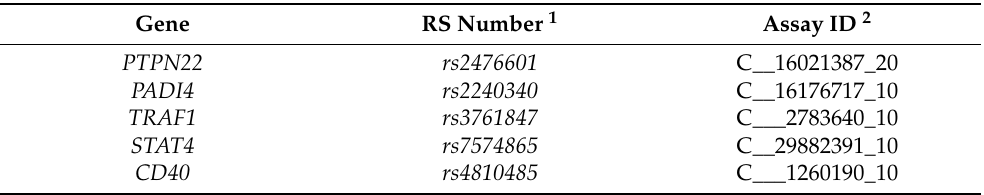
Table 8. Single nucleotide polymorphisms analyzed in this study. Gene RS Number 1 Assay ID 2